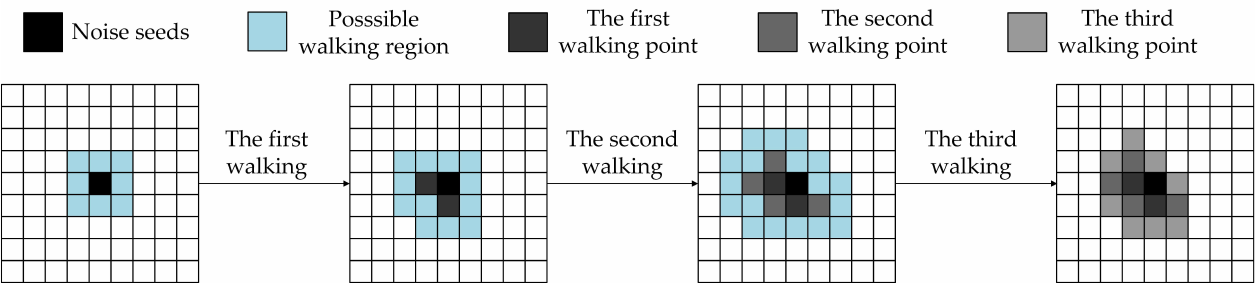
Figure 7. Random walk process of isolated noise